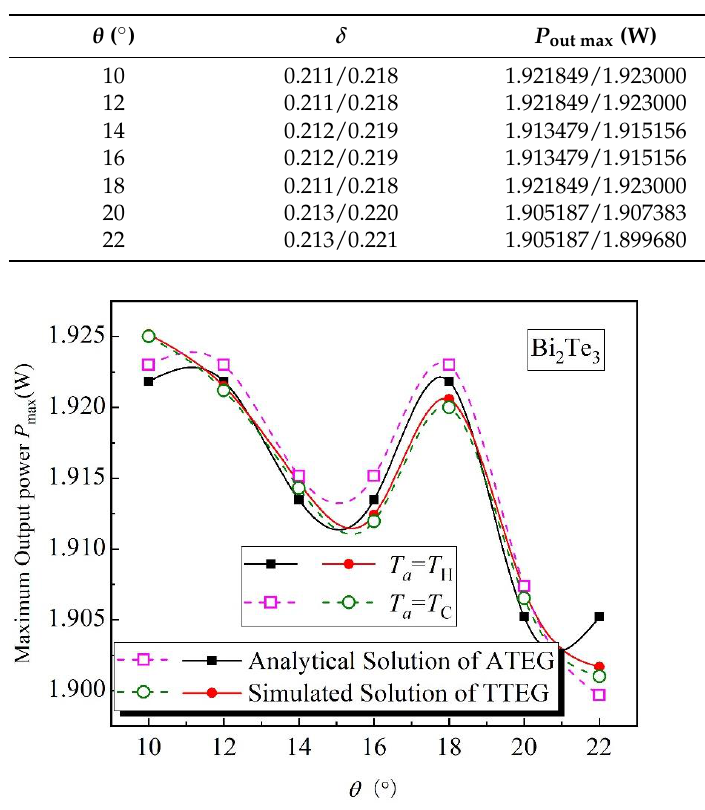
Figure 6. Maximum output power under different values of θ.